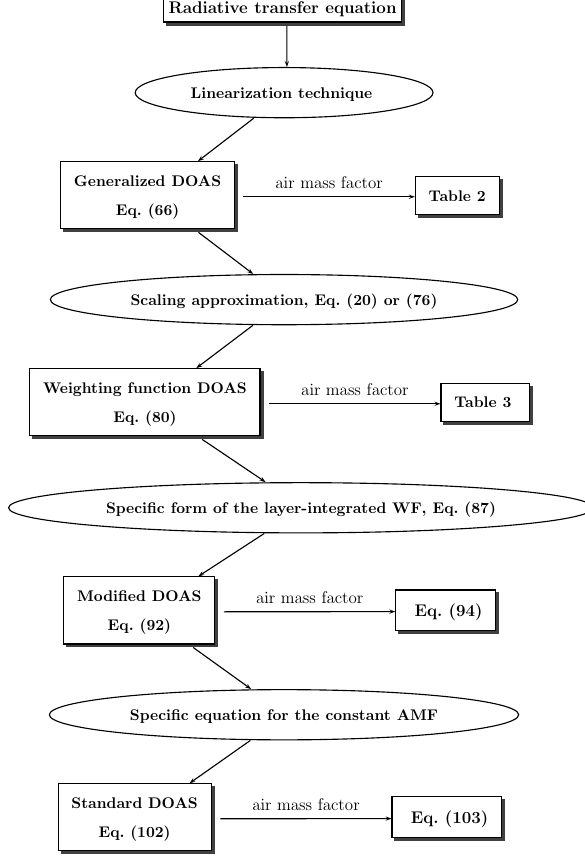
Specific form of the layer-integrated WF, Eq. (87)